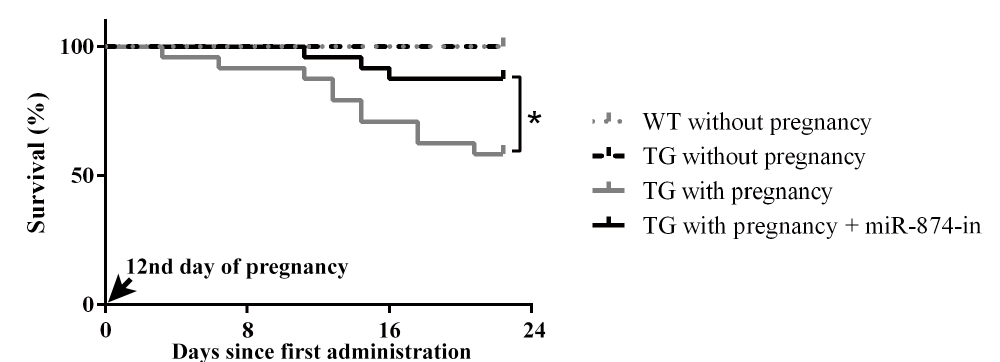
Figure 1. Kaplan-Meier survival analysis. All-cause mortality over course of experiment starting at day 12 after conception and 23 days continuous before euthanasia. All animals that entered study were included in this analysis. *p < 0.05 between the indicated groups, Log-rank (Mantel-Cox)